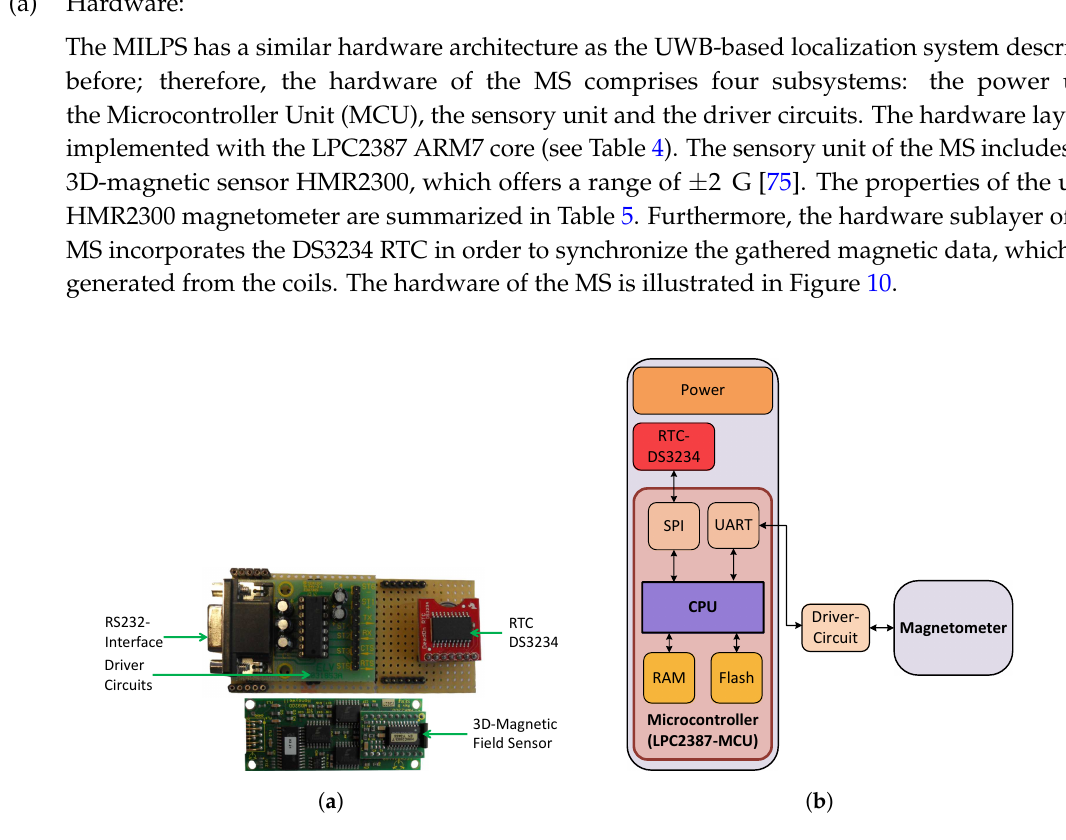
Figure 10. MILPS: Mobile station hardware. ( a ) Mobile station hardware, ( b ) simplified hardware block diagram. Table 4. The properties of the deployed LPC2387 MCU. [76].